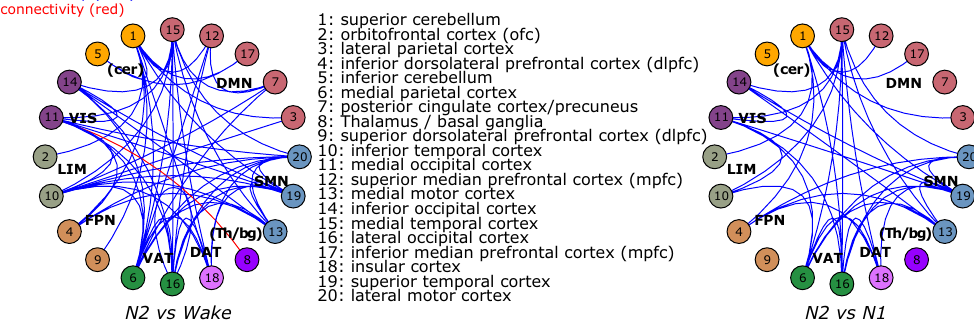
Figure 3. Similar age-group connectivity changes between N2 and wakefulness and between N2 and N1 sleep stage transition. This graph represents changes in functional connectivity between the clusters (two-way directionality) obtained from the data-driven parcellation (circles with numbers) shared by young and older individuals between N2 and wake (left side) and N2 and N1 (right side). Significant connectivity decreases (blue lines) were mostly observed whereas one connectivity increase (red line) was significant between N2 and wake. The seven Yeo’s large-scale networks partitioning the brain are presented with different colors: the default- mode network (DMN); the sensorimotor network (SMN); the dorsal attentional network (DAT); the ventral attentional network (VAT); the frontoparietal network (FPN); the limbic network (LIM) and the visual network (VIS). Clusters of the inferior and superior cerebellum (cer) and the thalamus/basal ganglia (Th/bg) were also added (see Fig. 2 for details on the subdivision of clusters).